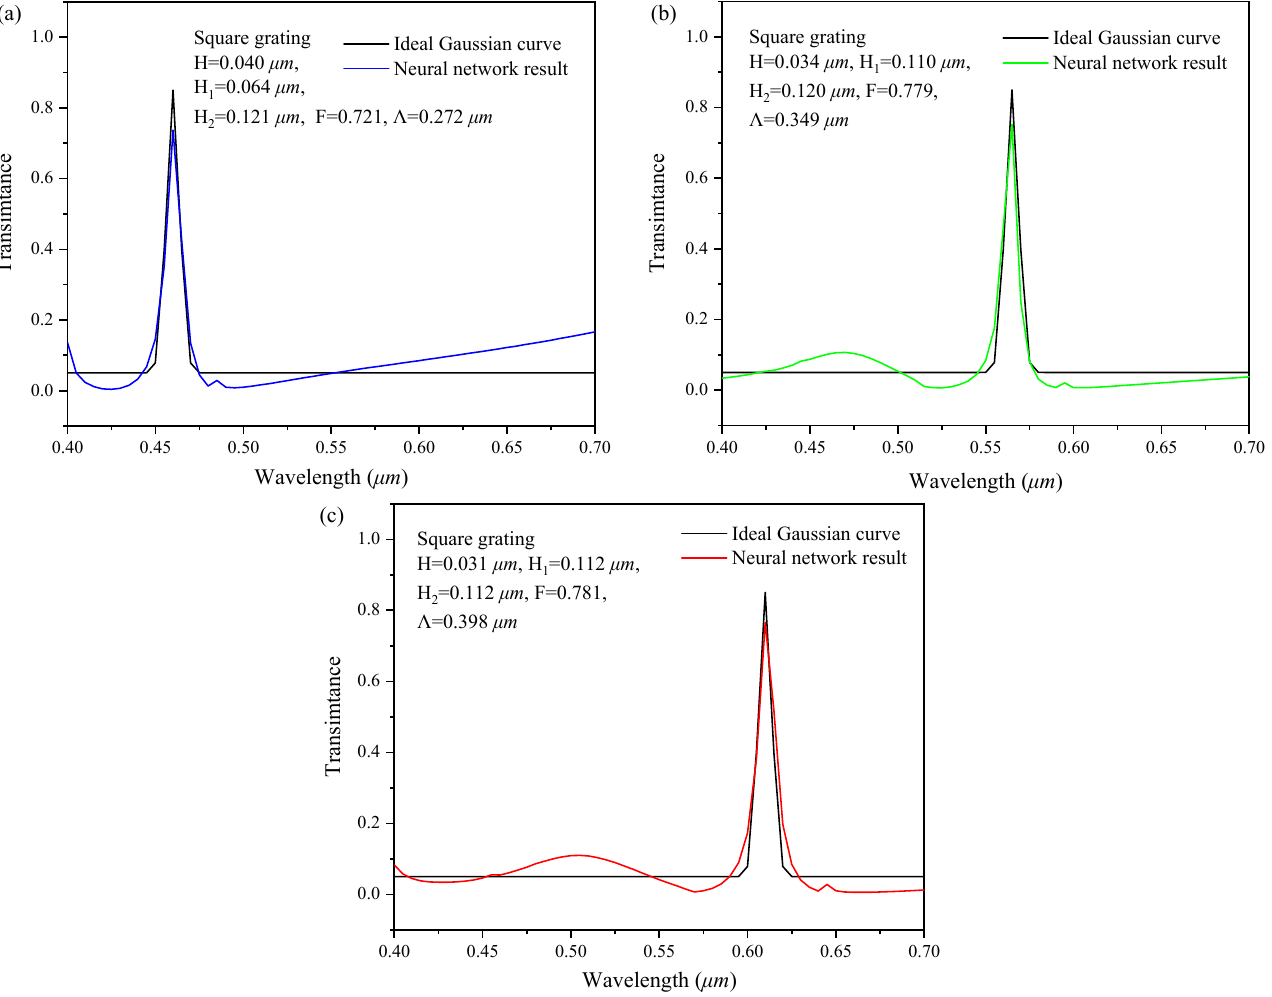
Figure 11. Validation of the ideal Gaussian curve. The peak wavelength: ( a ) 0.46 µm; ( b ) 0.56 µm; and ( c ) 0.61 µm. Insert picture in the upper-left corner of each figure shows the designed structure parameters by the inverse network.